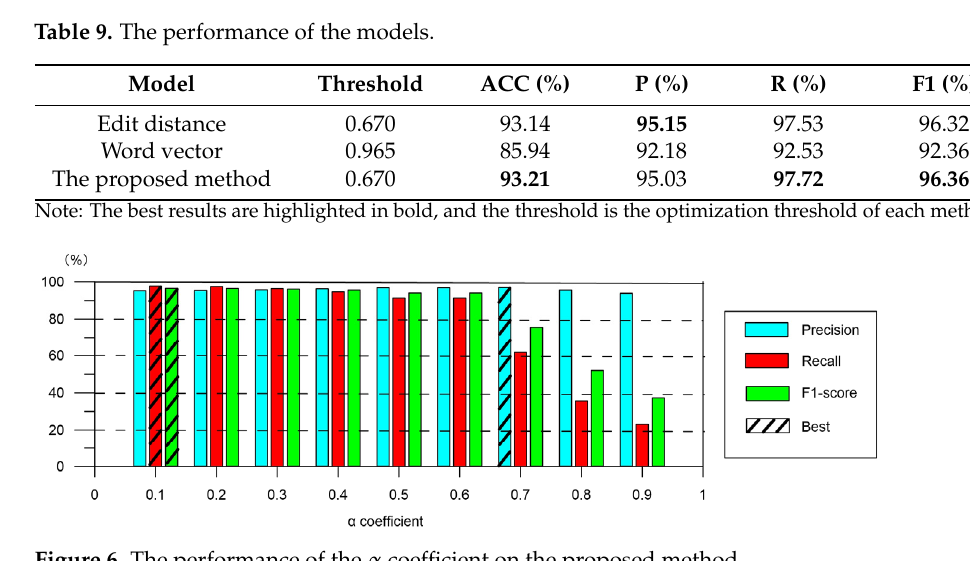
Figure 6. The performance of the α coefficient on the proposed method.